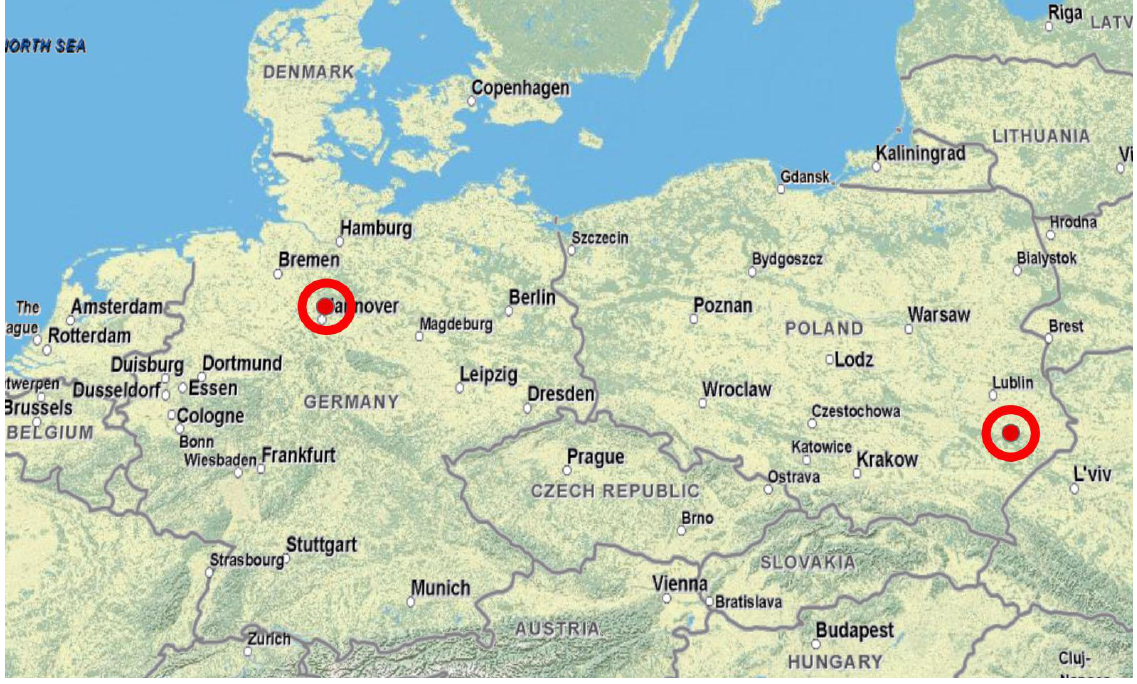
Figure 2. Location of study areas. (© ESRI online resources [28]).